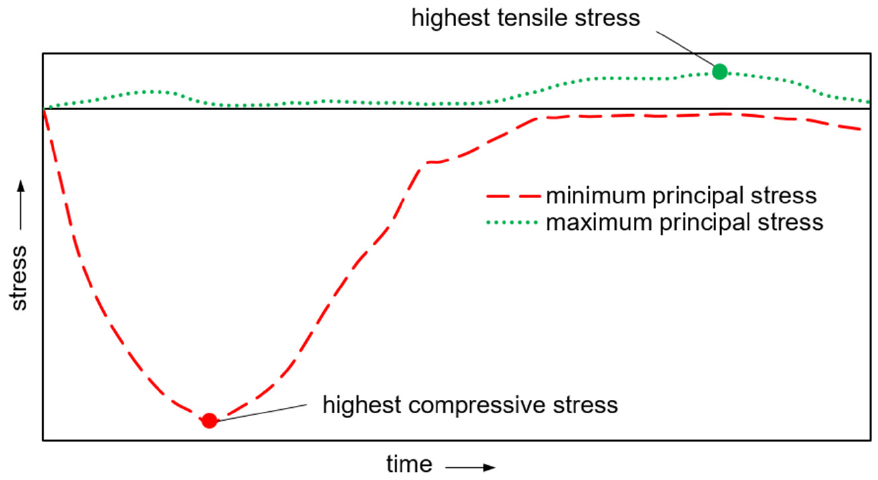
Figure 14. Qualitative representation of induced stress at particle impact over time.